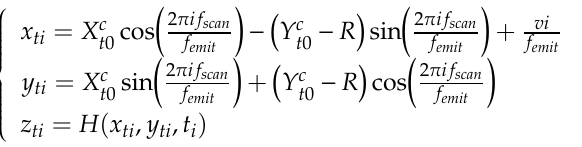
Figure 7. The incident angles of the laser light in a laser beam. For every mesh node in point set (cid:2420) (cid:3047)(cid:3036) , the vector of the light line falling on the node can be obtained as: